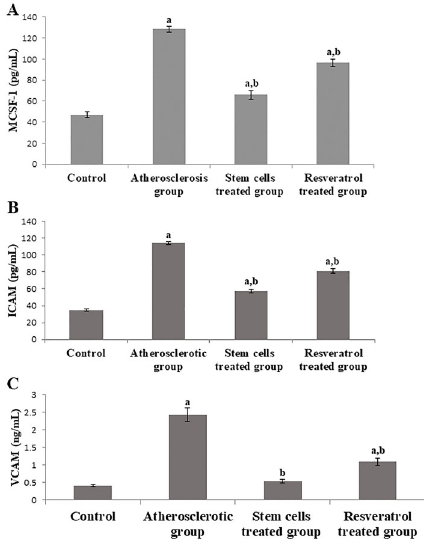
Figure 2. Protein levels of macrophage-colony stimulating factor 1 (MCSF-1) ( A ), intracellular adhesion molecule (ICAM) ( B ), and vascular cell adhesion molecule (VCAM) ( C ) in groups of rats experimentally induced with atherosclerosis, treated with stem cells or resveratrol, and control. Data are reported as means ± SE. a P o 0.05 compared to control group; b P o 0.05 compared to atherosclerotic group (ANOVA).